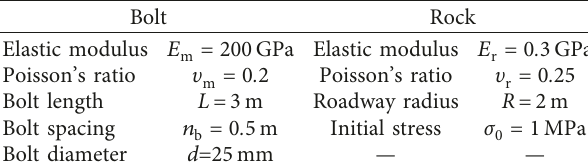
Table 1: Mechanical parameters of rock bolt and rock